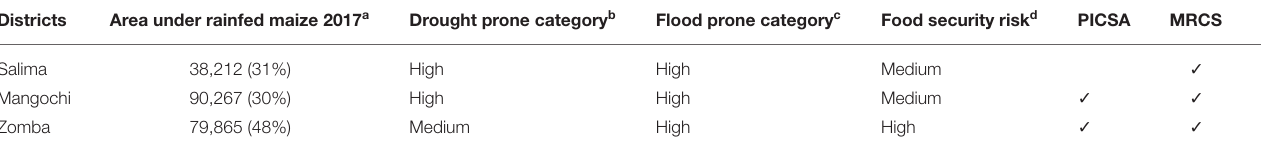
TABLE 1 | Criteria for selecting the pilot districts. Districts